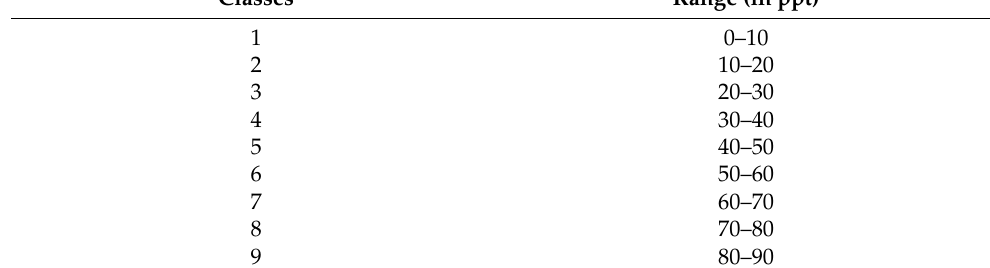
Table 1. Distribution of salt concentrations in the respective classes.